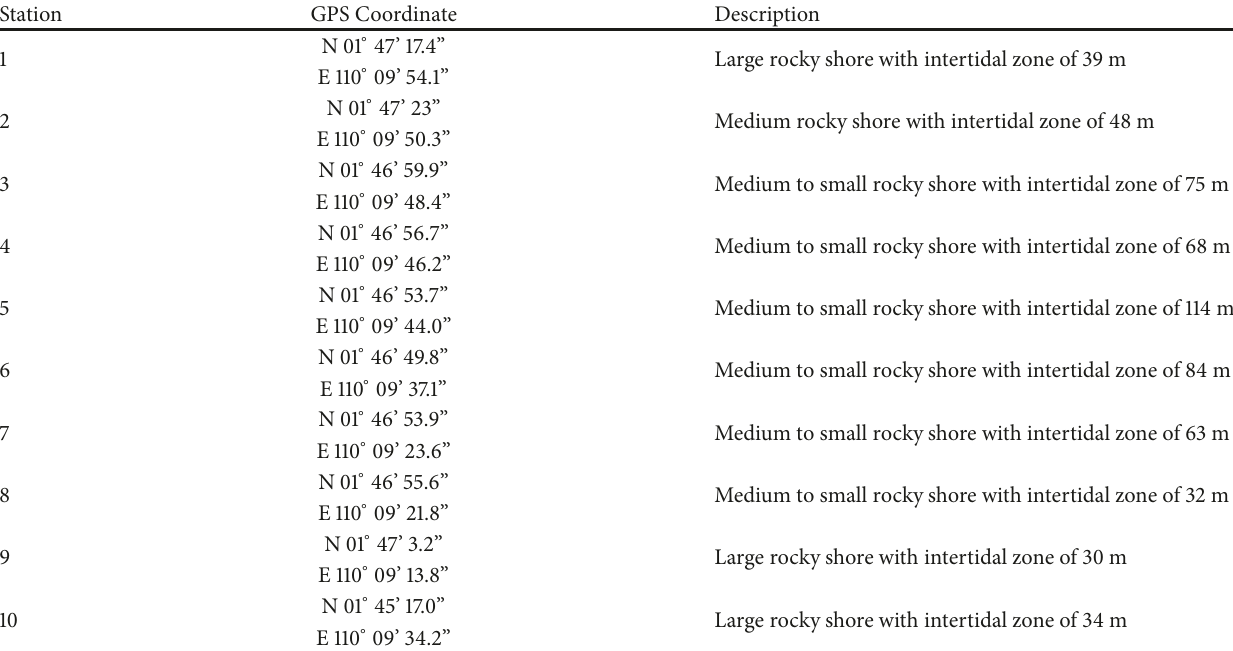
Table 1: Coordinates of sampling stations with their habitat